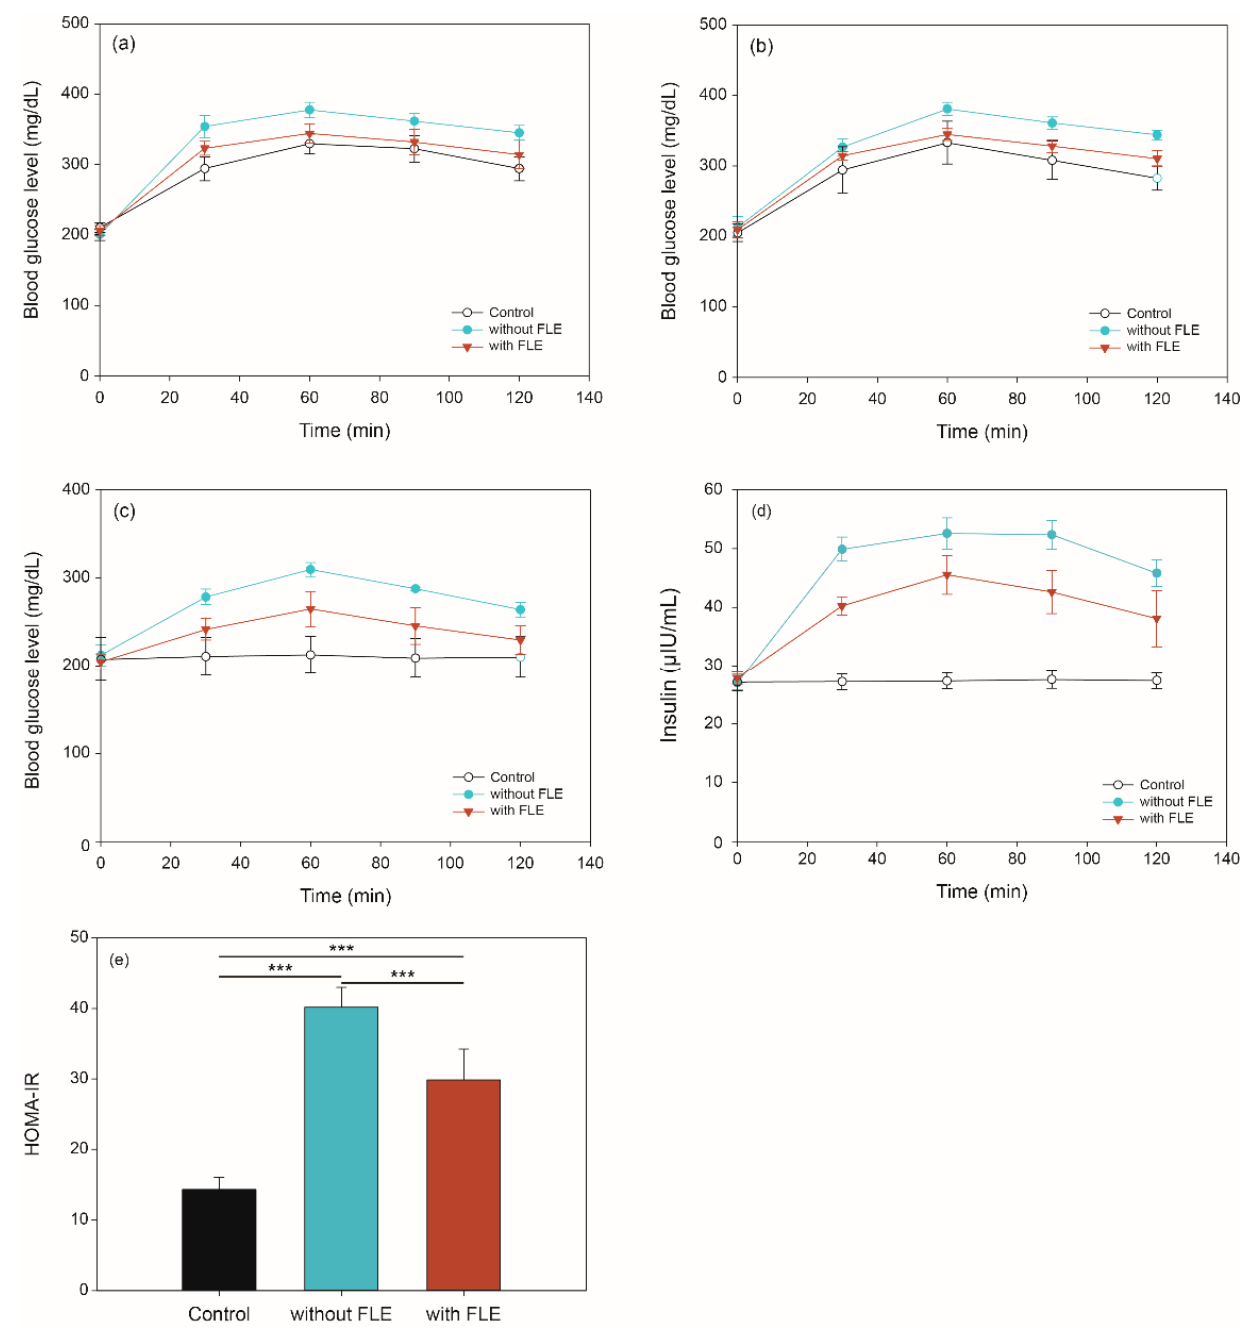
Figure 2. Blood glucose in ( a ) oral glucose, ( b ) sucrose tolerance, and ( c ) fasting blood glucose tests, as well as ( d ) insulin levels and ( e ) HOMA-IR values of mice given distilled water (control), feed standard noodles (without fermented lettuce extract [FLE]), and feed noodles with FLE (with FLE). Significant difference set as *** p <